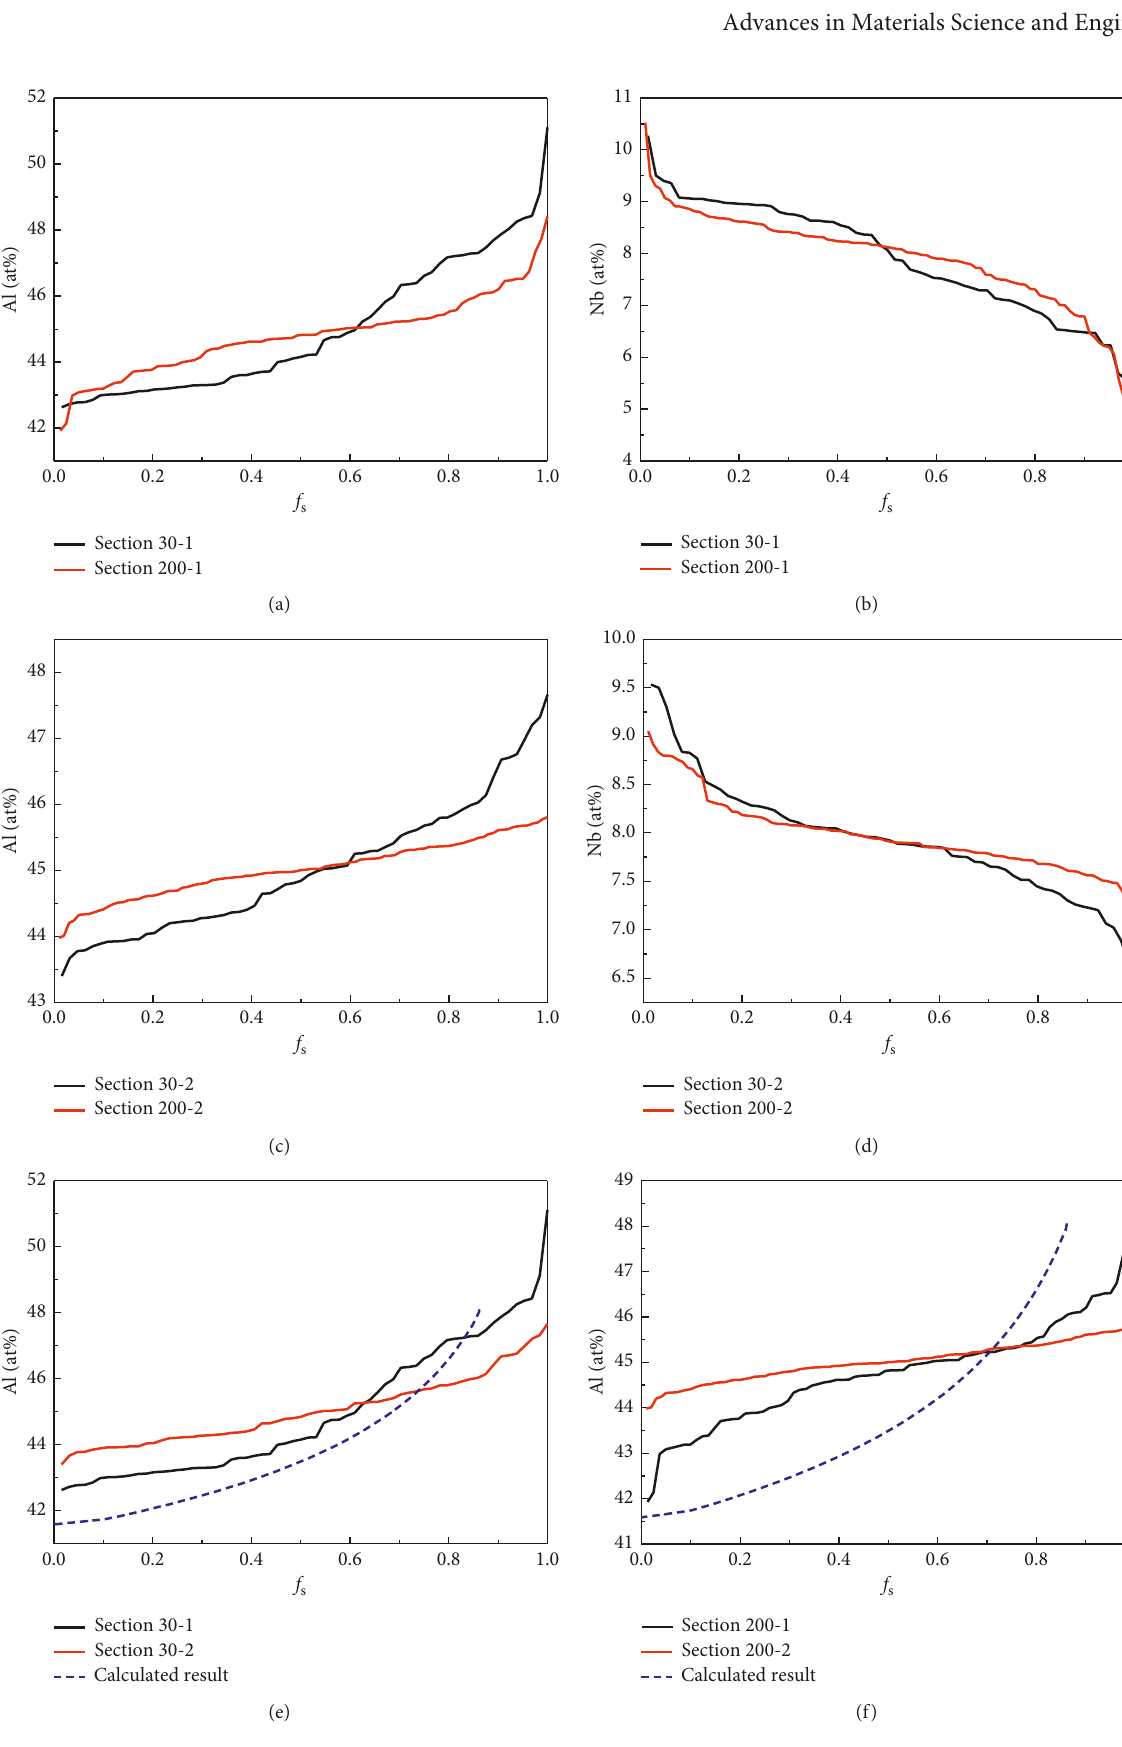
Figure 6: Measured concentration profiles as a function of solid fraction: (a) Al in mushy zone; (b) Nb in mushy zone; (c) Al in columnar zone; (d) Nb in columnar grains; (e) Al in the two sections of 30 μ m/s withdrawn ingot; (f) Al in the two sections of 200 μ m/s withdrawn